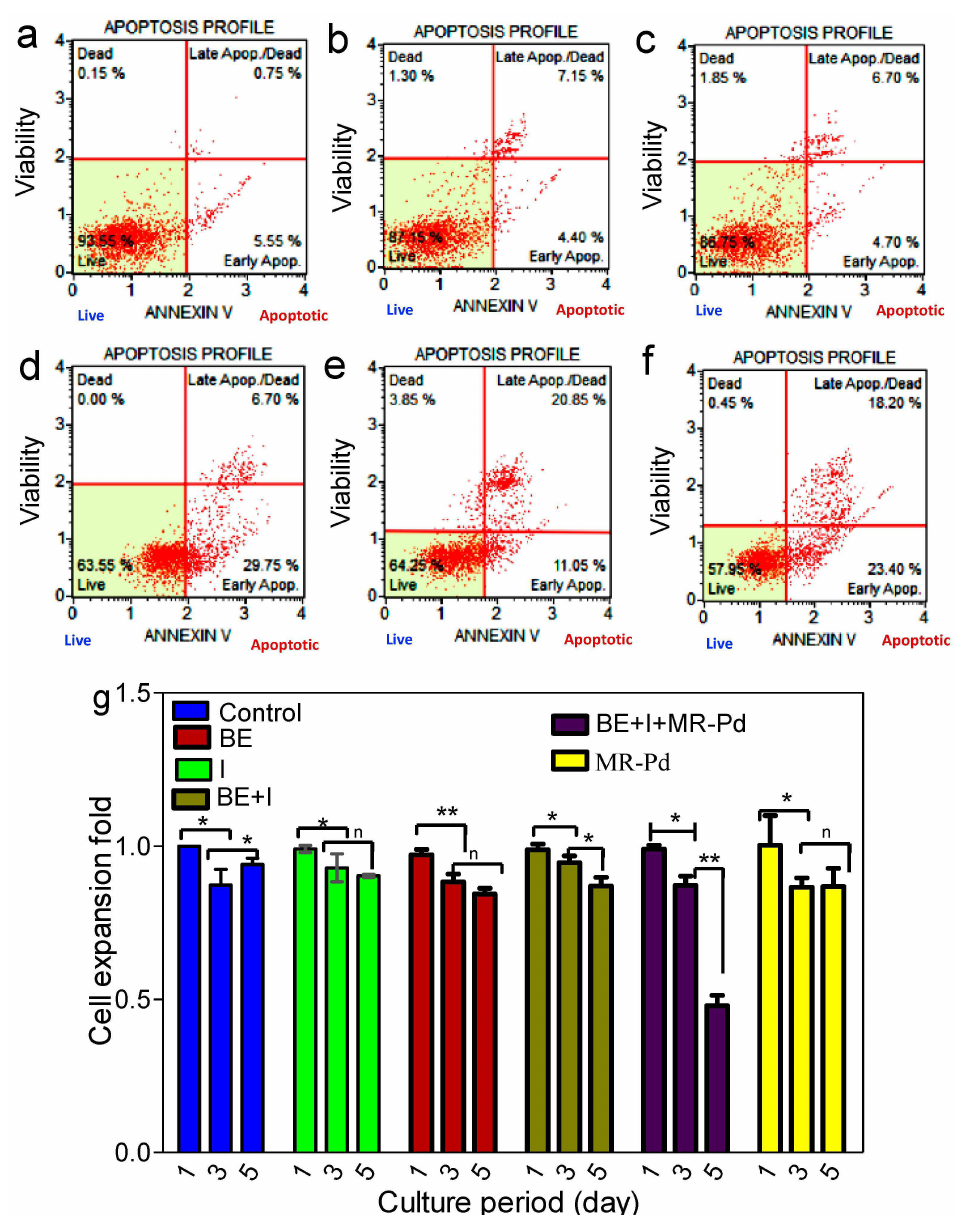
Figure 2. ( a – c ) In situ drug synthesis for monolayer PC-3 cells, Control, without catalyst: ( a ) Control day 1 ( b ) Control on day 3, ( c ) Control on day 5. ( d – f ). In situ drug synthesis in present of MR-Pd catalyst: ( d ) with catalyst, day 1 ( e ) with catalyst, day 3, ( f ) with catalyst, day 5 (Cell viability results based on flowcytometry assay). ( g ). Cell expansion fold based on presto blue assay [BE = Boronic Ester, I = Iodoprazole, MR-Pd = Mesoporous Catalyst]. Statstical ignificance showed using p -value on bar graph. “*” signifies p ≤ 0.05 (statistically significant), “**” signifies p ≤ 0.01 (highly statistically significant